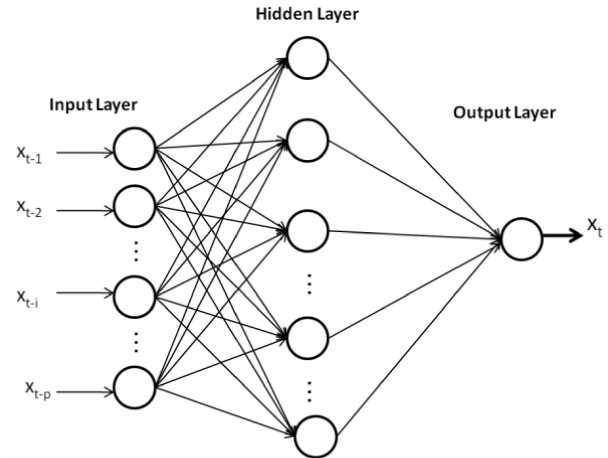
Fig. 1. Architecture of three layers feed-forward back-propagation